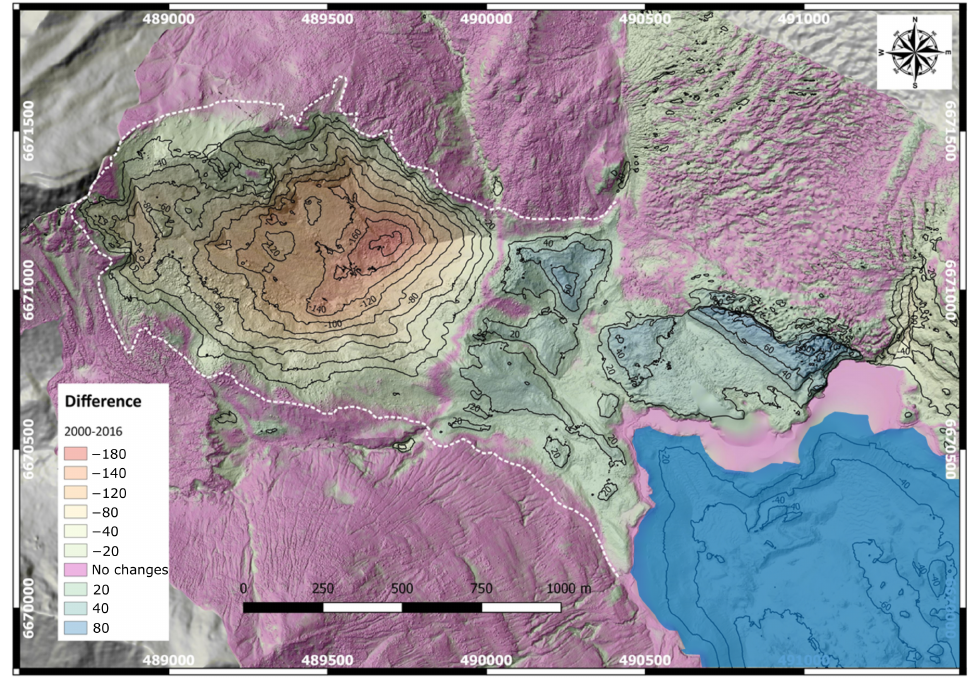
Figure 3. DEM of difference (DOD) [57] for the landslide area from 2000 to 2016. The white dotted line represents the margin of the landslide area. The purple colour corresponds to the lack of identified changes in elevation for locations of the slope or the glacier (Figure exported from